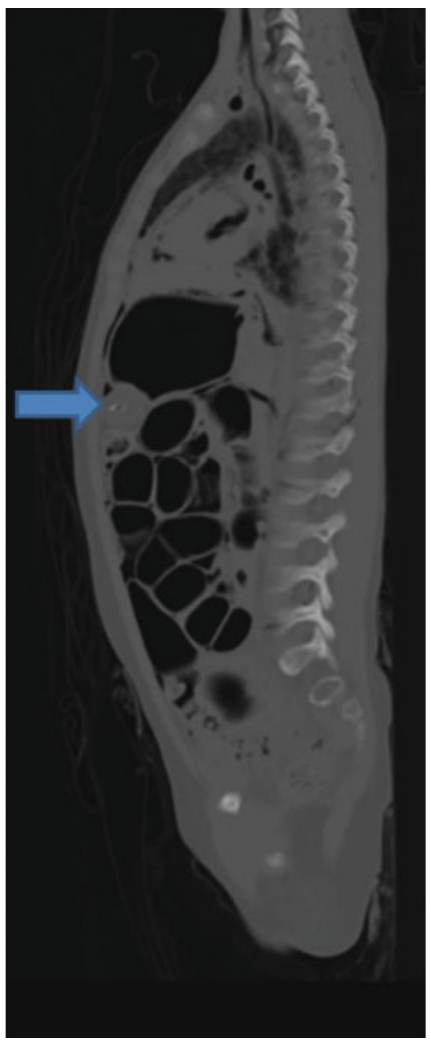
Fig. 4 An 8-year-old girl died of peritonitis after malpositioning of a gastrostomy feeding tube into the peritoneal cavity. The postmortem computed tomography demonstrates the balloon of the MIC-KEY just outside the stomach